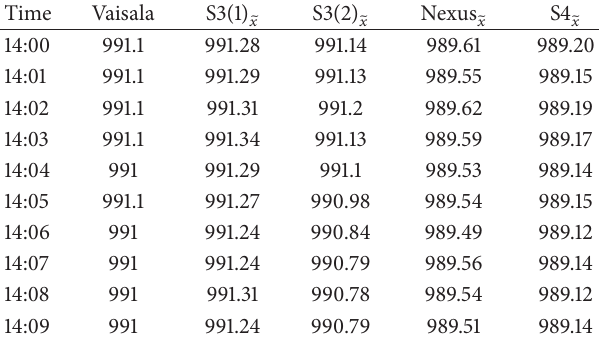
Table 3: Sample pressure data for uncertainty calculation. Figure 2: Setup of the moving user experiment.